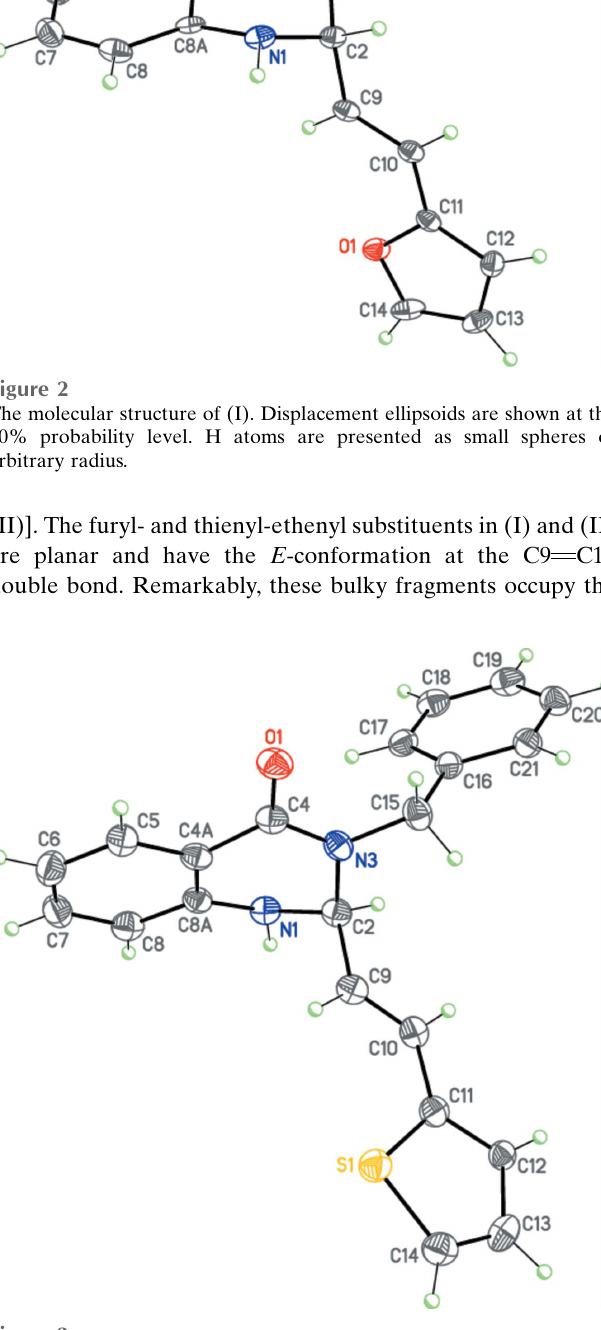
Figure 3 The molecular structure of (II). Displacement ellipsoids are shown at the 50% probability level. H atoms are presented as small spheres of arbitrary